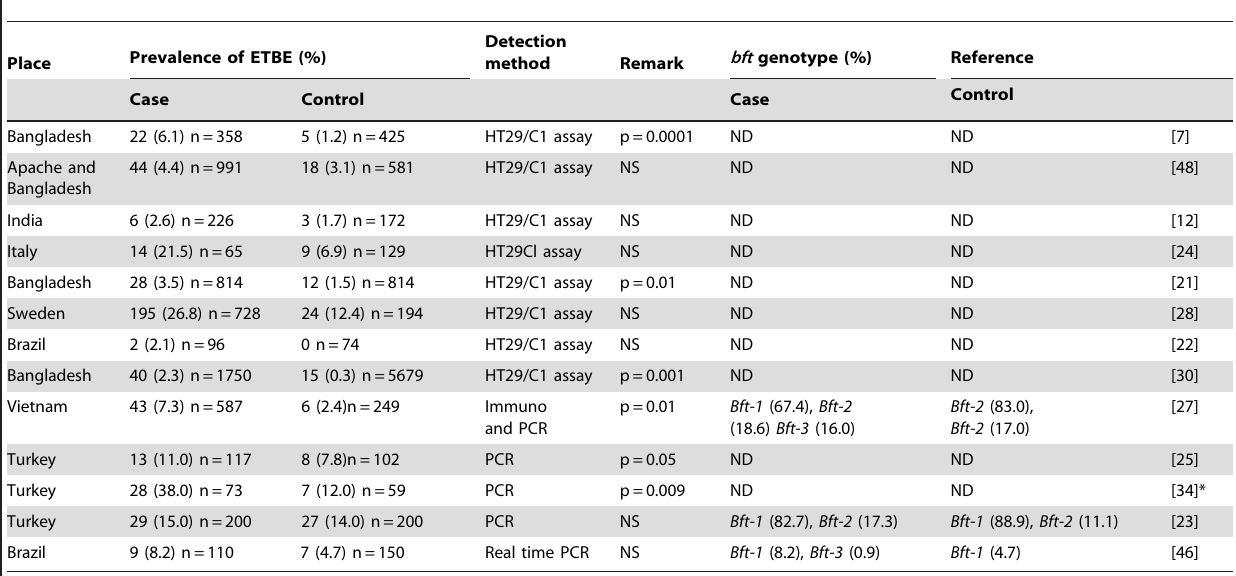
Table 3. Prevalence of enterotoxigenic Bacteroides fragilis in diarrheal cases and controls in different studies.